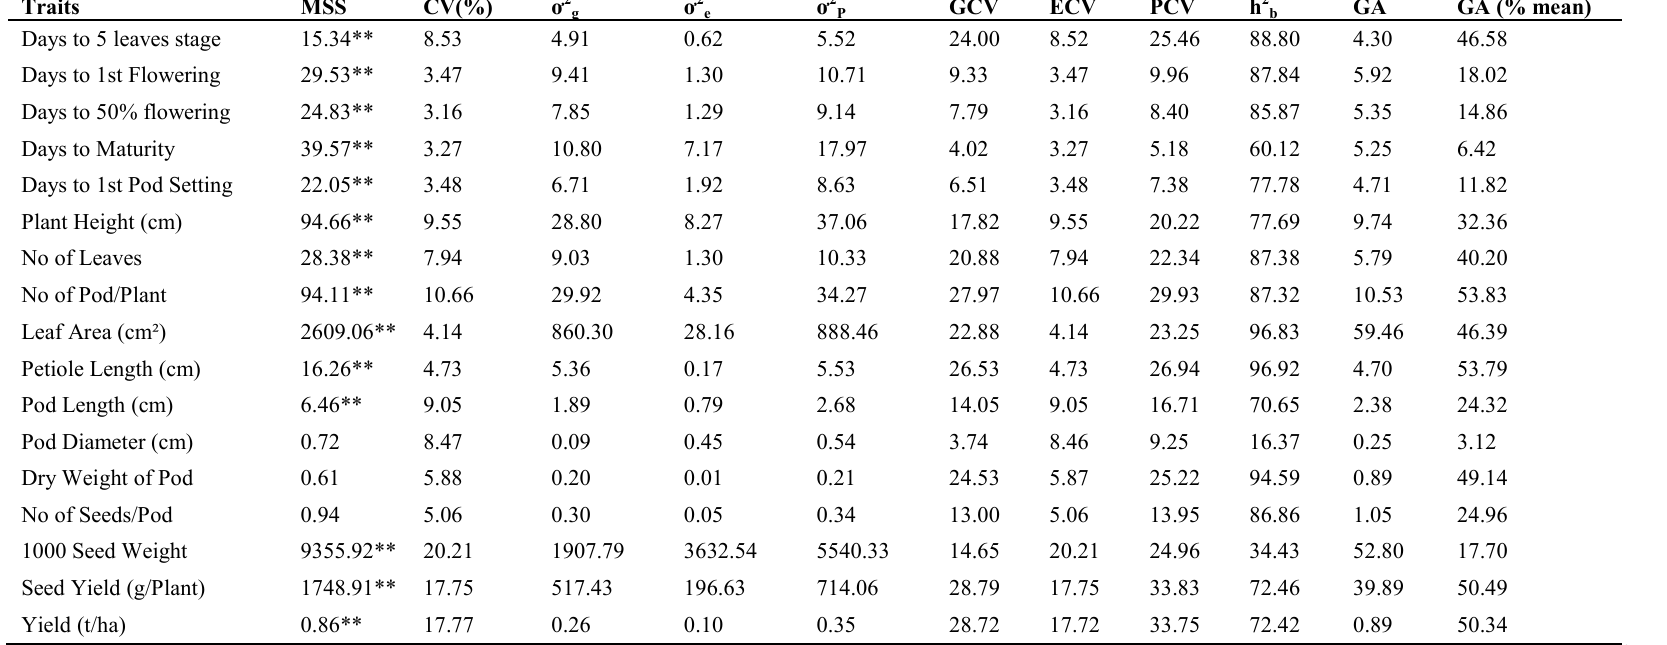
Note: ** indicates significant at 1% level, Gen MSS: Genetic mean sum of square, CV: Coefficient of variation, ơ 2 g: Genotypic variance, ơ 2 P: Phenotypic variance, ơ 2 e: Environmental variance, GCV: Genotypic coefficient of variance, PCV: Phenotypic coefficient of variance, h 2 b: Heritability in broad sense, GA: Genetic advance, GA (% of mean): Genetic advance as percent of